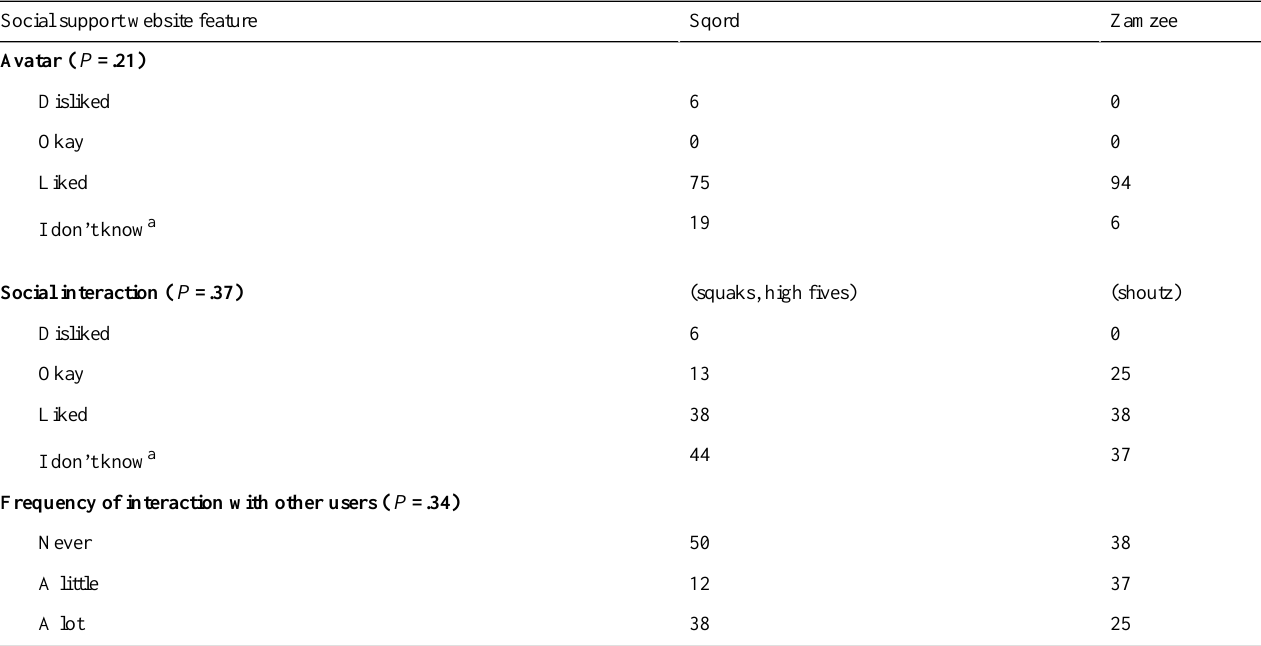
Table 1. Survey responses (percent) related to social support website features for the Sqord and Zamzee. The MovBand contained no social support features and therefore was not included is these